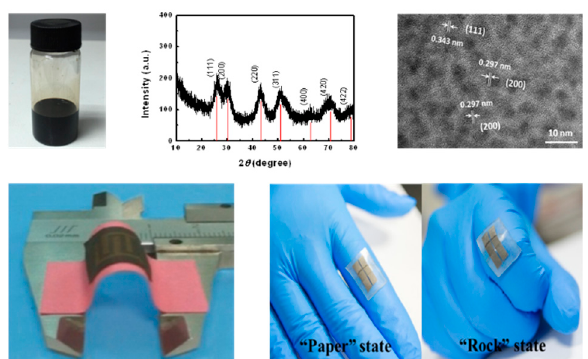
Figure 1. Colloidal quantum dots for low-power-consumption semiconductor gas sensors. Reproduced with permission from Huan Liu; Physically flexible, rapid-response gas sensor based on colloidal quantum dot solid [1] and Fully stretchable and humidity-resistant quantum dot gas sensors [2]; published by Wiley (2014) and the American Chemical Society (2018),